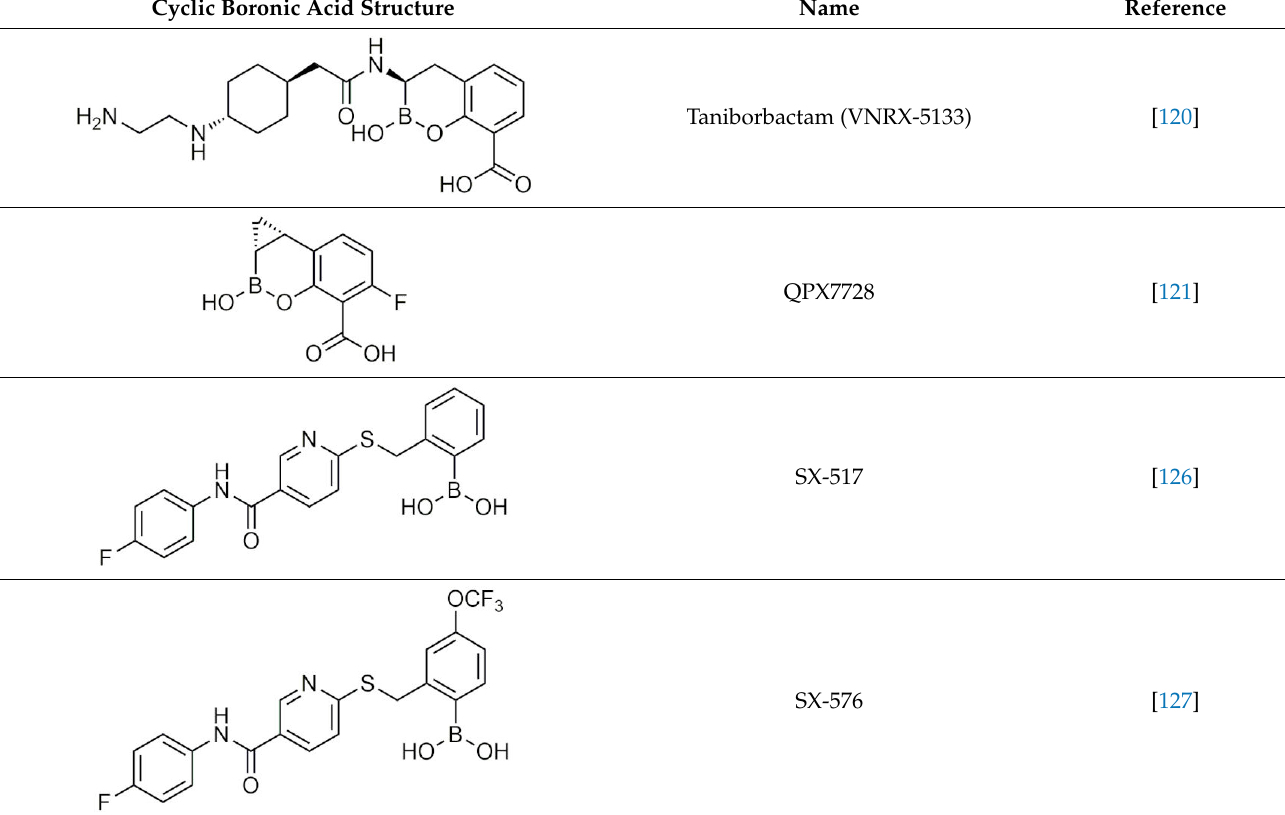
Table 5. Cyclic boronic acid as β -lactamase inhibitors and anti-inflammatory drugs. Cyclic Boronic Acid